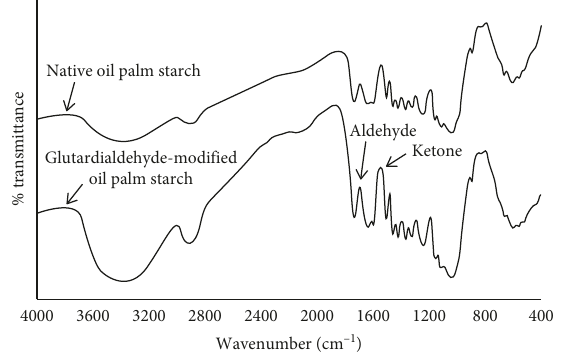
Figure 2: FT-IR spectra of powdered samples from wood com- posite made using OPSMG and OPS.